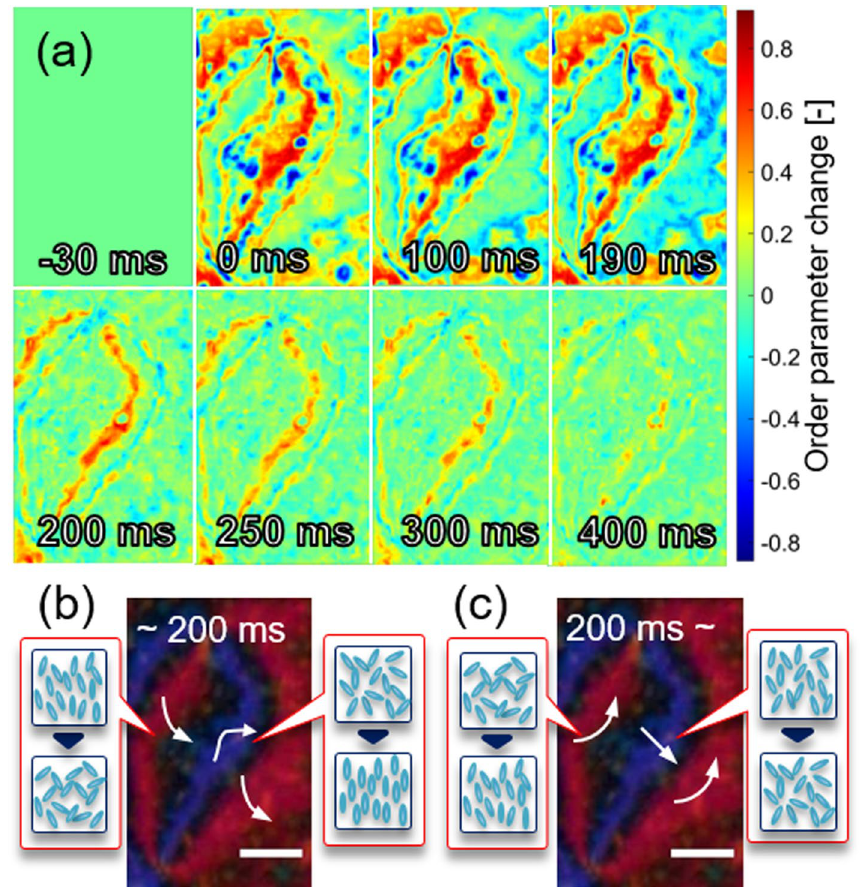
Figure 4. (a) A time sequence of the order parameter change under the UV light irradiation is shown. The UV light was irradiated from 0 to 200 ms. The difference from the original order parameter obtained in Fig. 3 is shown. (b,c) The summarized drawings of the change in the order parameter at each pair of brushes (b) during and (c) after light irradiation (prepared by PowerPoint